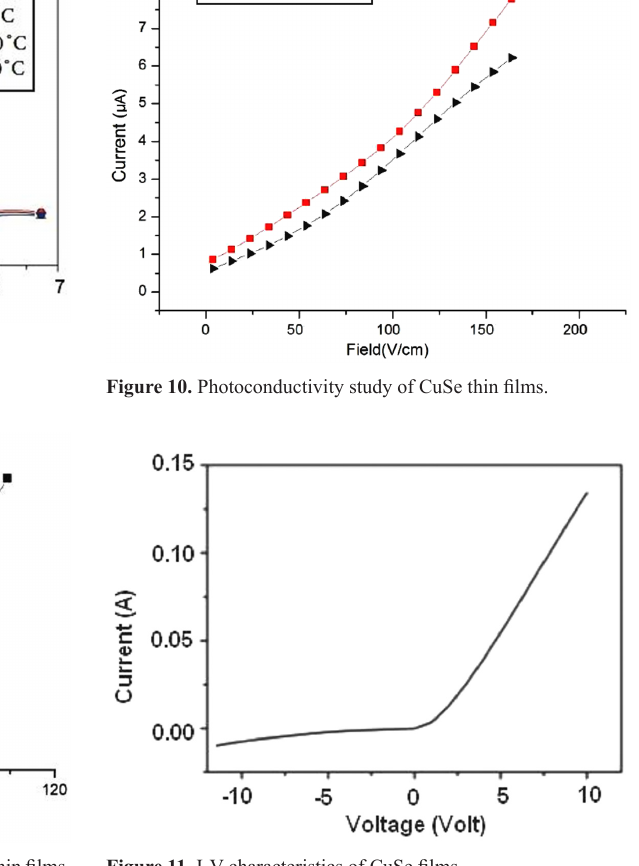
Figure 9. Temperature dependent conductivity of CuSe thin films.